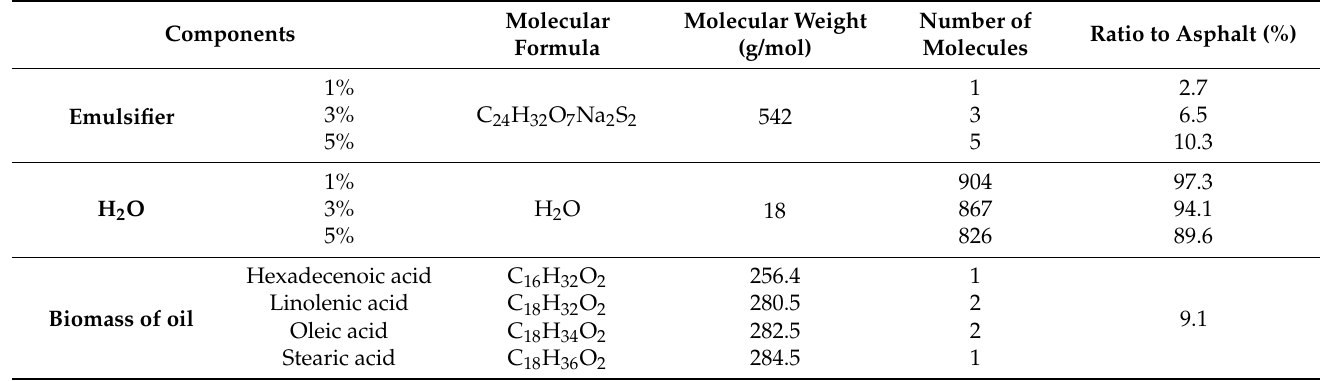
Table 4. Molecular parameters of other components of bio-oil asphalt/water